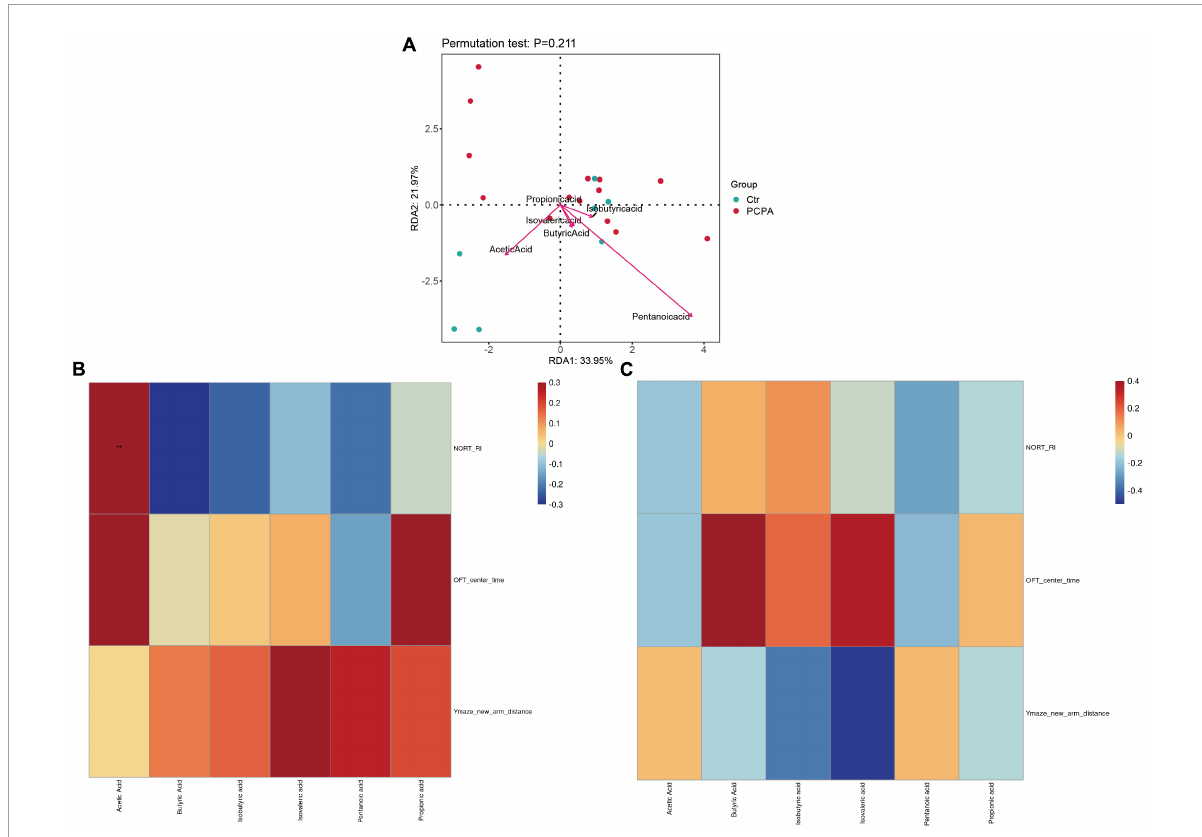
FIGURE4 Correlation of short-chain fatty acids (SCFAs) levels with dysbiosis and cognitive impairment. (A) Correlations between the SCFAs and gut microbiota. (B) Heatmap of corrections between SCFAs and behavioral tests of the para-chlorophenylalanine (PCPA) group. (C) Heatmap of corrections between SCFAs and behavioral tests of the Control